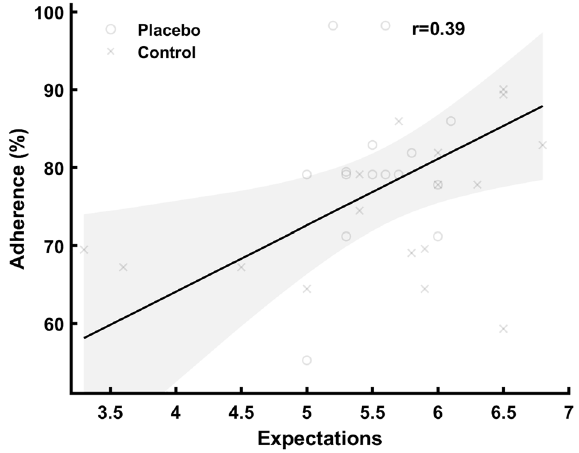
Figure 4. Correlation between the adherence to the training program and expectations toward the training intervention. Adherence is measured as percentage of completed scheduled training sessions and expectation using SETS (Stanford Expectations of Treatment